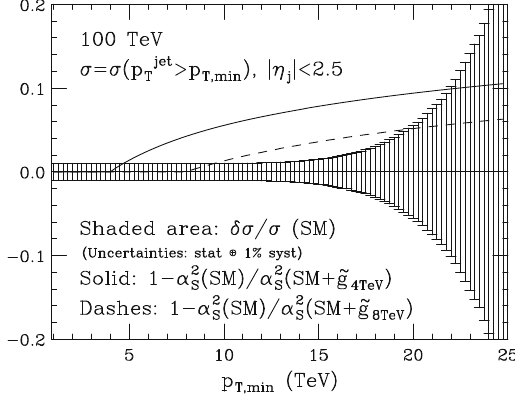
Right plot: the gluino mass that can be probed with a 3 σ deviation